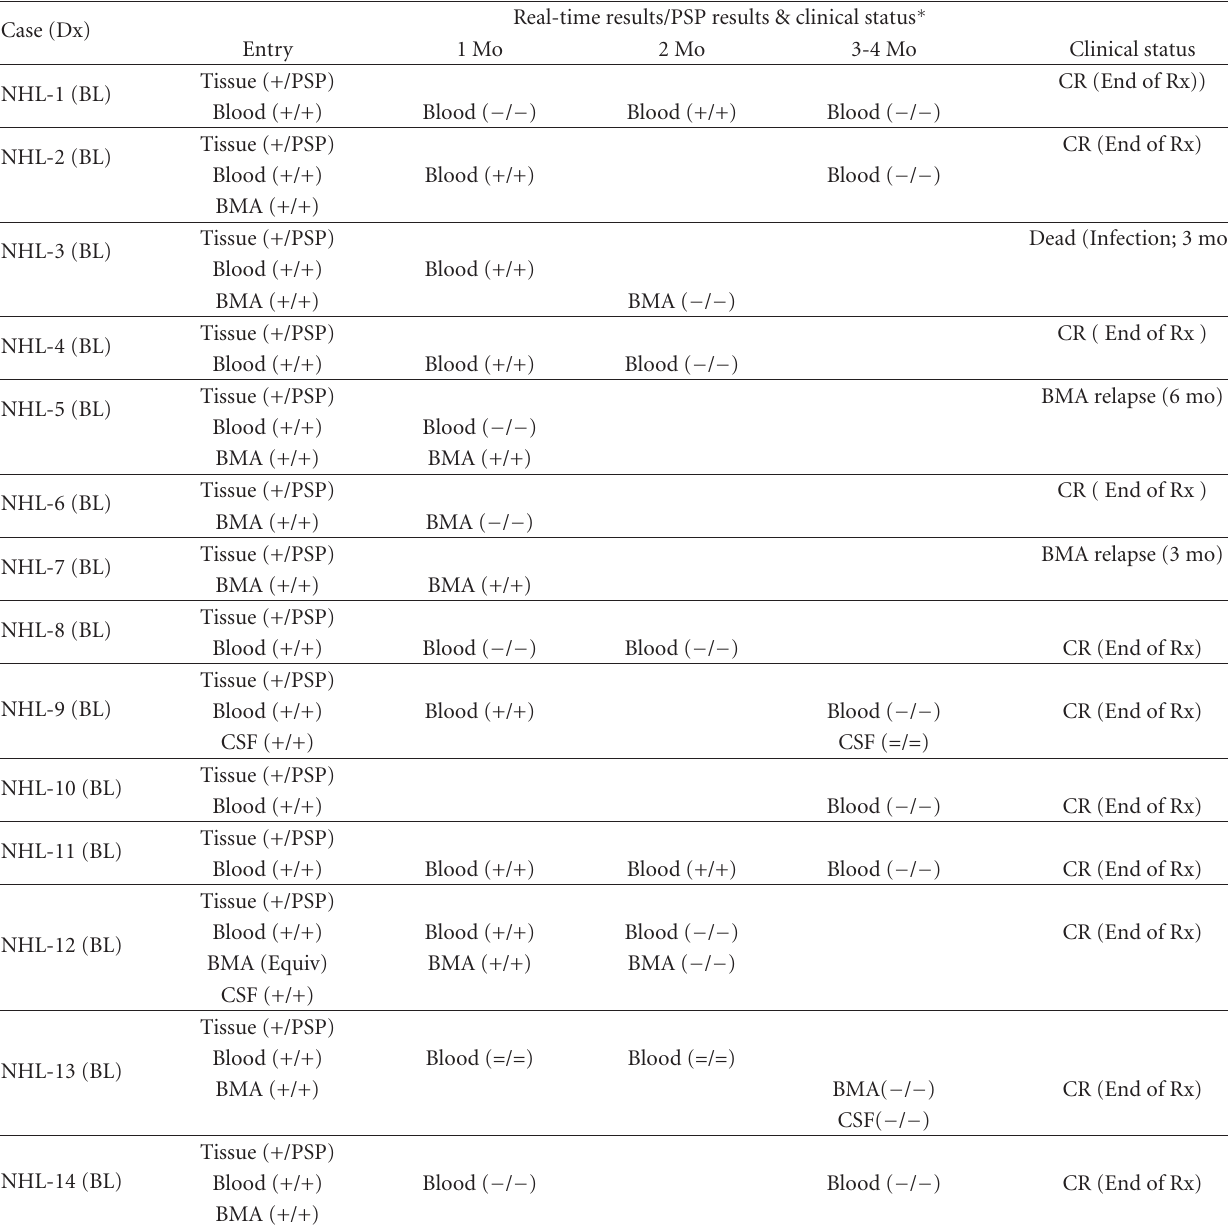
Table 1: Persistent or minimal residual disease assessment using real-time and PSP